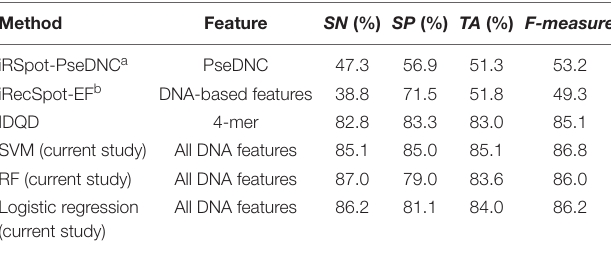
TABLE 2 | The performances of several models in discriminating recombination hot/cold spots (feature range = 300 bp). Method